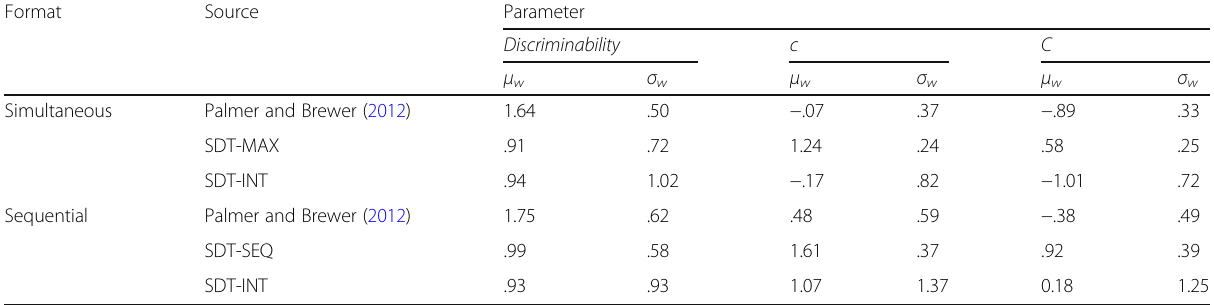
Table 3 Mean parameter values weighted by sample size calculated from the estimates reported in Palmer and Brewer (2012) and our